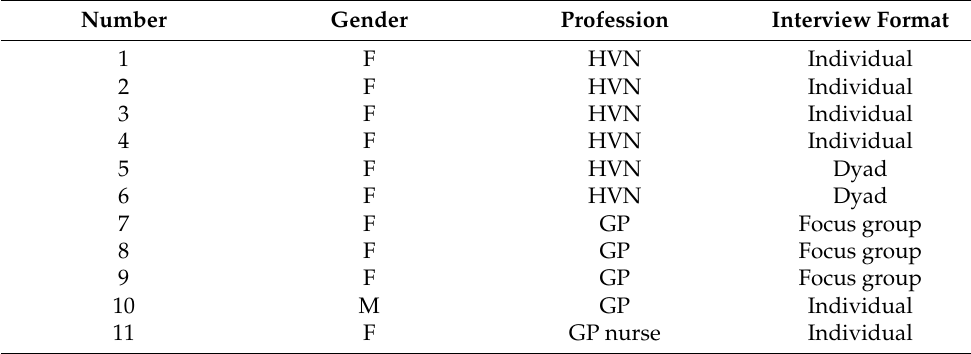
Table 2. Characteristics of participating healthcare